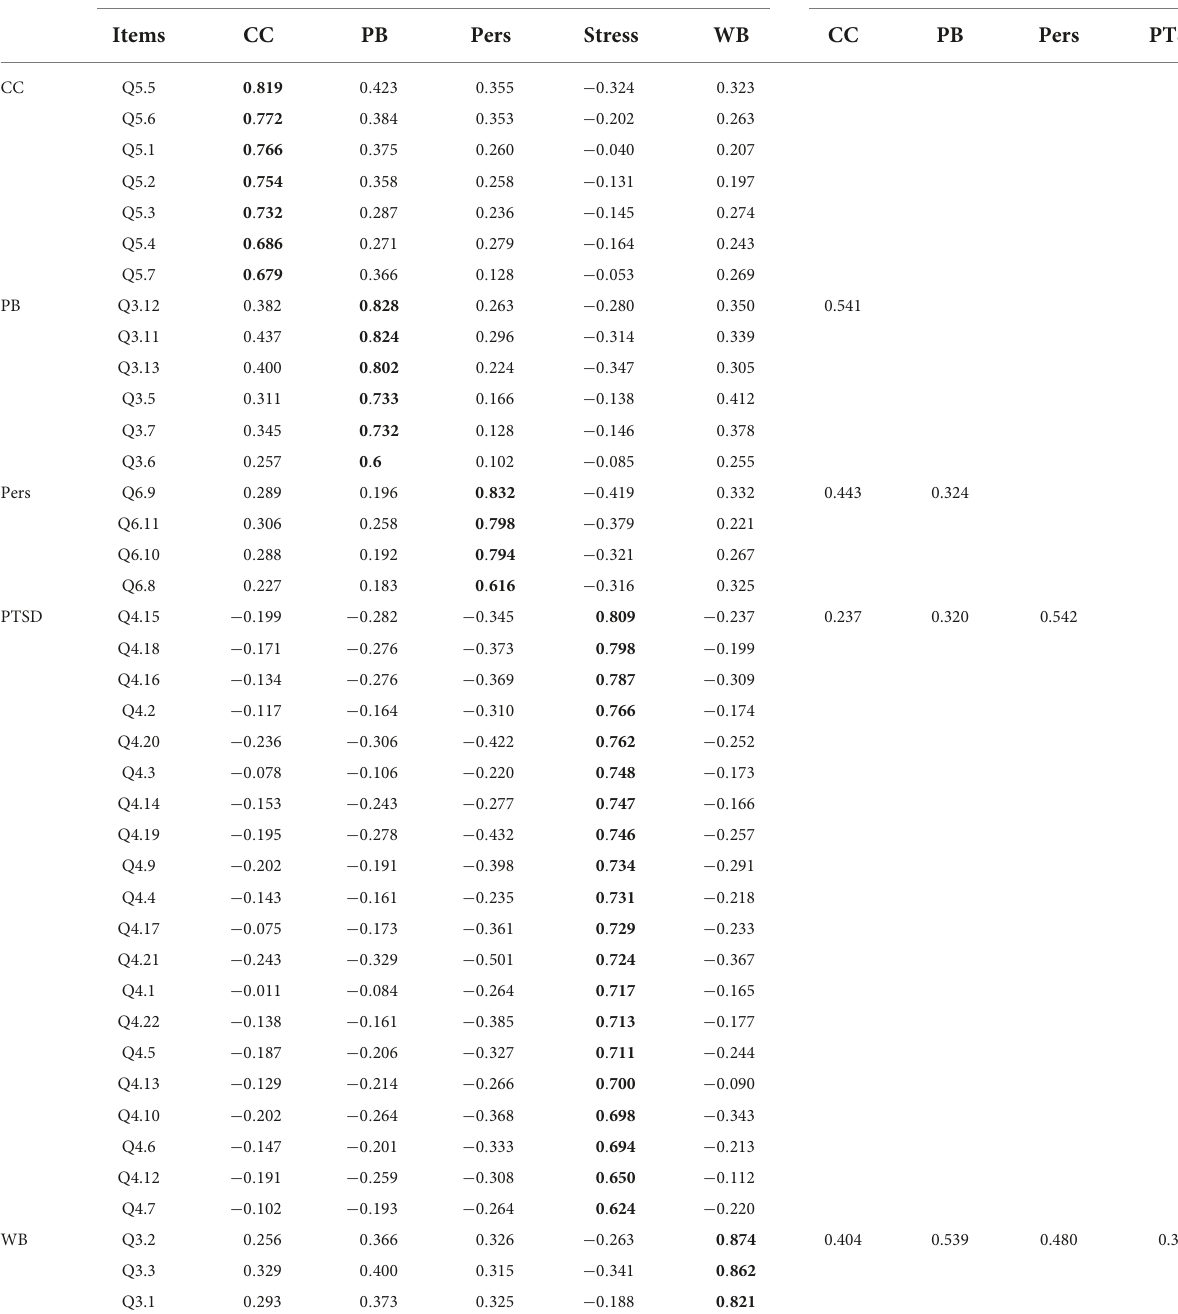
TABLE 2 Cross loading and Heterotrait-Monotrait Ratio